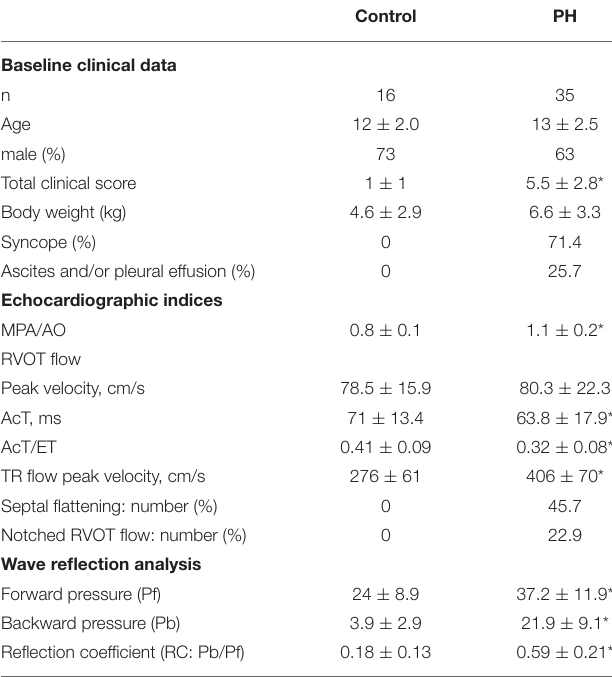
TABLE 1 | Baseline clinical data and echocardiographic variables.